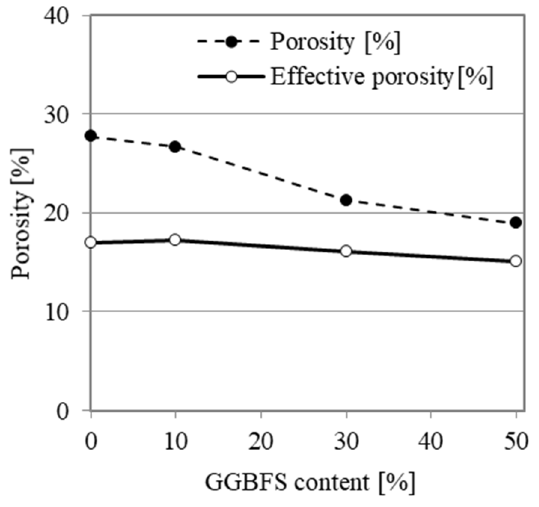
Figure 6. Porosity of AA mortars relative to GGBFS